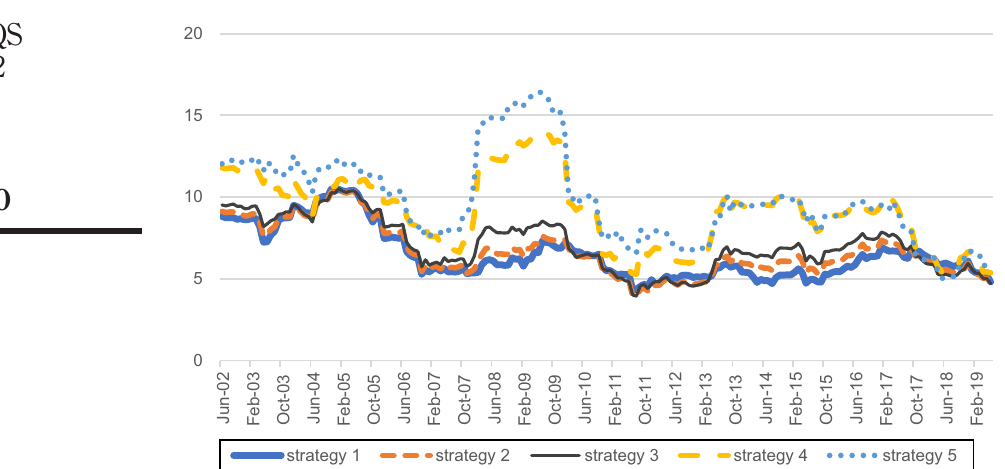
Figure 4. Time-series of tracking errors estimated from style timing strategy: